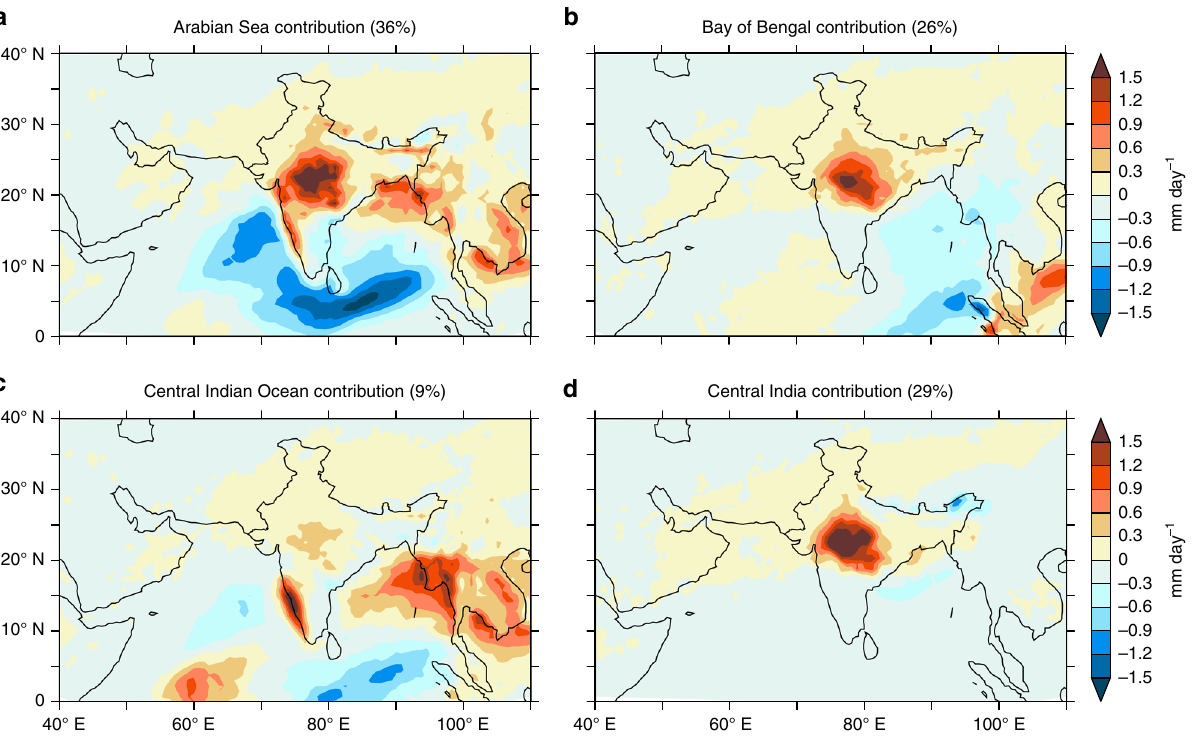
Fig. 4 Moisture contribution from ocean and terrestrial sources. Contribution of a Arabian Sea (50° – 75° E, 5° S – 30° N), b Bay of Bengal (80° – 100° E, extreme precipitation events over central Indian subcontinent. The moisture contribution is estimated using the Dynamic Recycling Model. The colors indicate individual source ’ s contribution to the precipitation anomaly in mm day − 1 . The negative precipitation anomalies (mm day − 1 ) south of the subcontinent indicate de fi cient rainfall because of the northward shift in rainfall bands during extreme rainfall events over central India. The anomaly is calculated as deviation from the seasonal mean precipitation. The percentages in the subheadings show the fractional contributions of moisture to the extreme precipitation over the selected region in central India from different